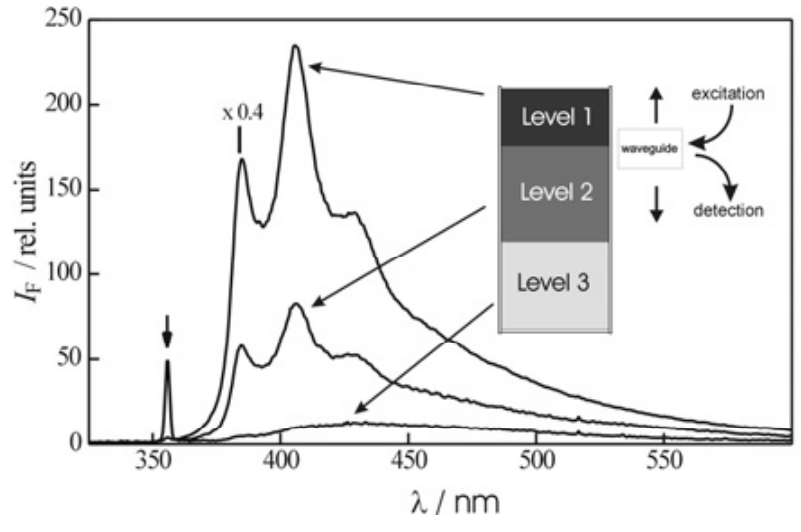
Figure 5. LIF spectra of hydraulic oil 2 on a column packed with a sandy loam.